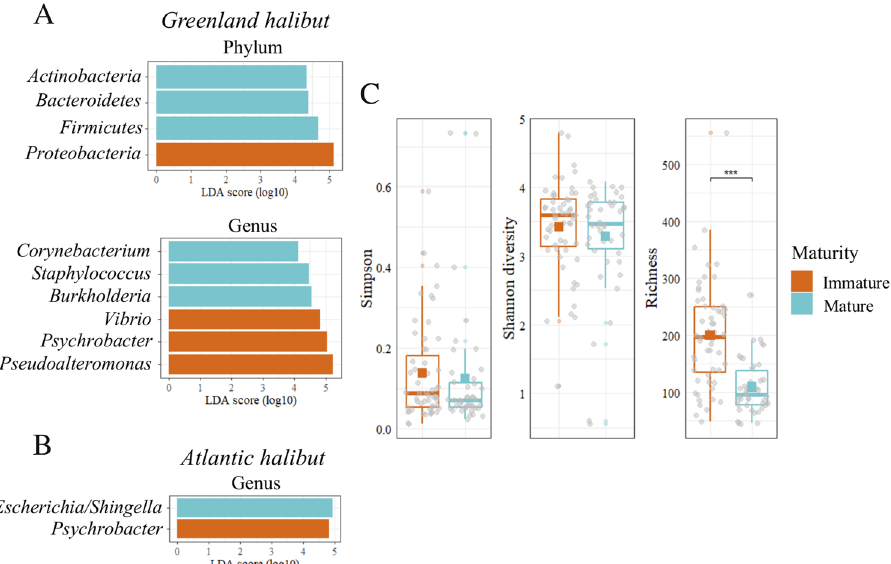
Figure 5. Maturity analysis. LEfSe analysis of the blood microbiome showing the significantly different taxa in mature (blue) and immature (red) fish in ( A ) Greenland halibut (Immature, n = 55, mature, n = 42) and ( B ) Atlantic halibut (Immature, n = 56, mature, n = 25). ( C ).α-Diversity metrics for immature and mature Greenland halibut. ***: p < 0.001.